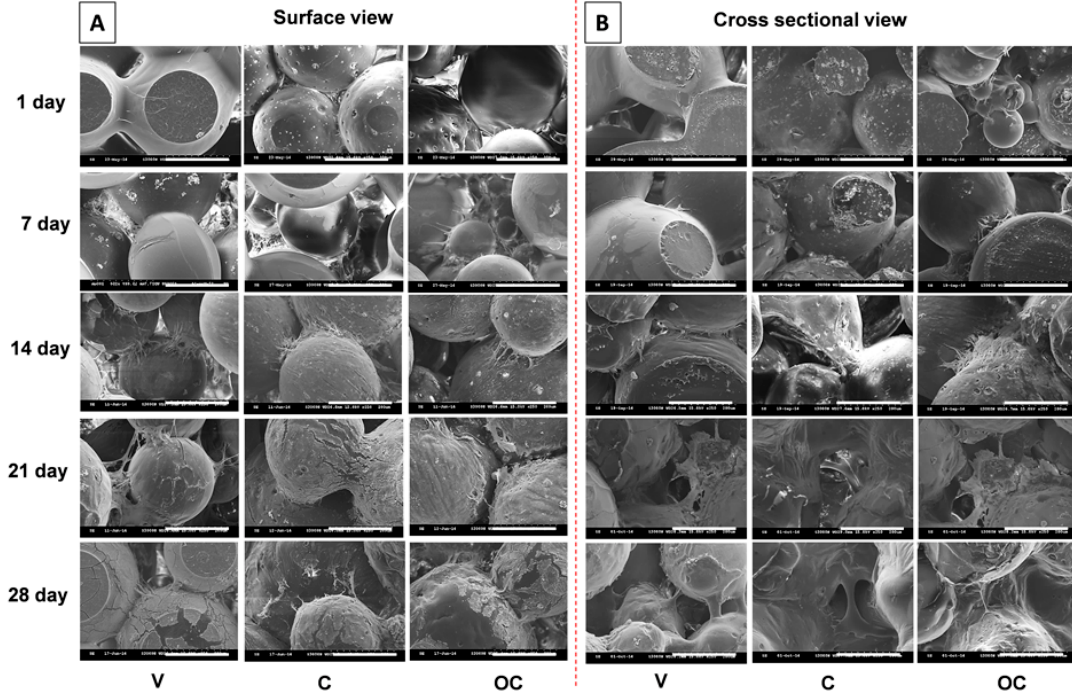
Figure 4. Cell infiltration and cell morphology of BMSCs (bone marrow stem cells) in V, C, and OC scaffolds. The increased cell density and spreading from day 1 to day 28 from SEM images of scaffold surface ( A ) and cross section ( B ) validates the biocompatibility and pore interconnectivity in all scaffolds. Bar = 200 µm